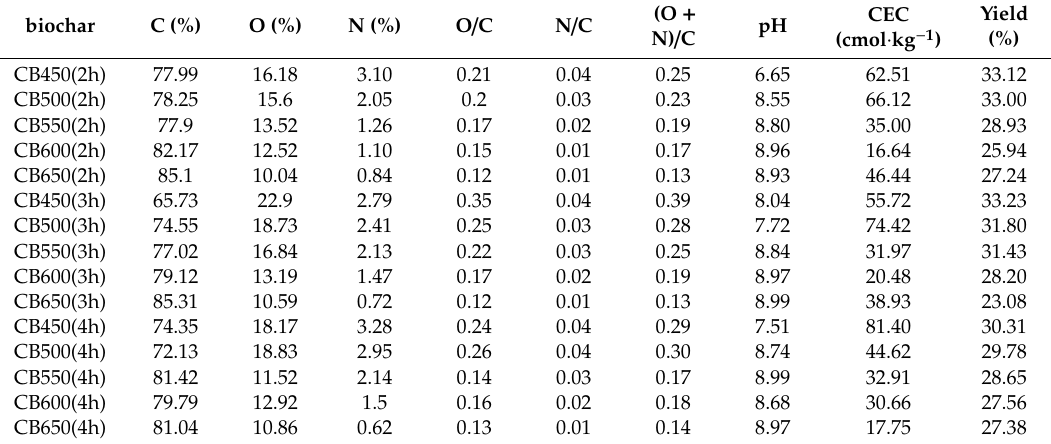
Table 2. Basic physical and chemical properties of biochar produced from Caragana korshinskii .